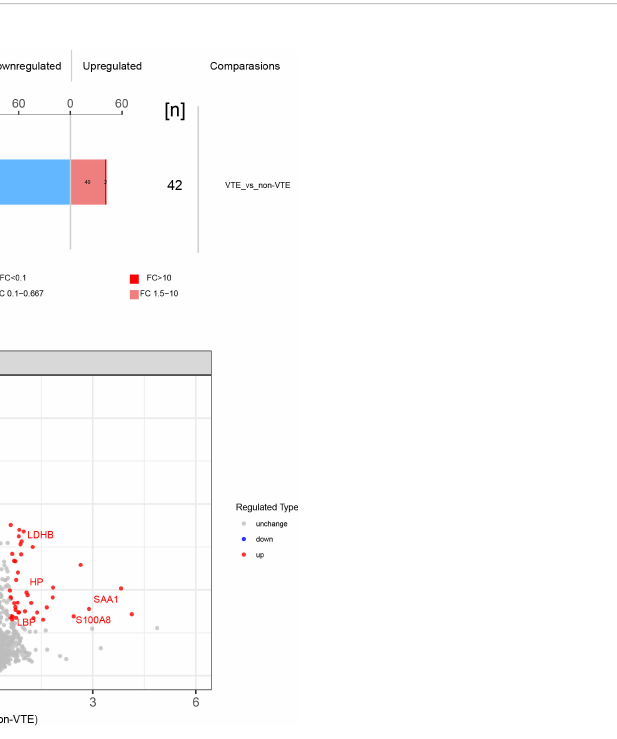
FIGURE 2 Differentially expressed proteins identi fi ed. (A) 280 differentially expressed proteins between VTE group and non-VTE group were screened. (B) Volcano plot of proteins identi fi ed. Red ones stand for the upregulated and blue ones for downregulated